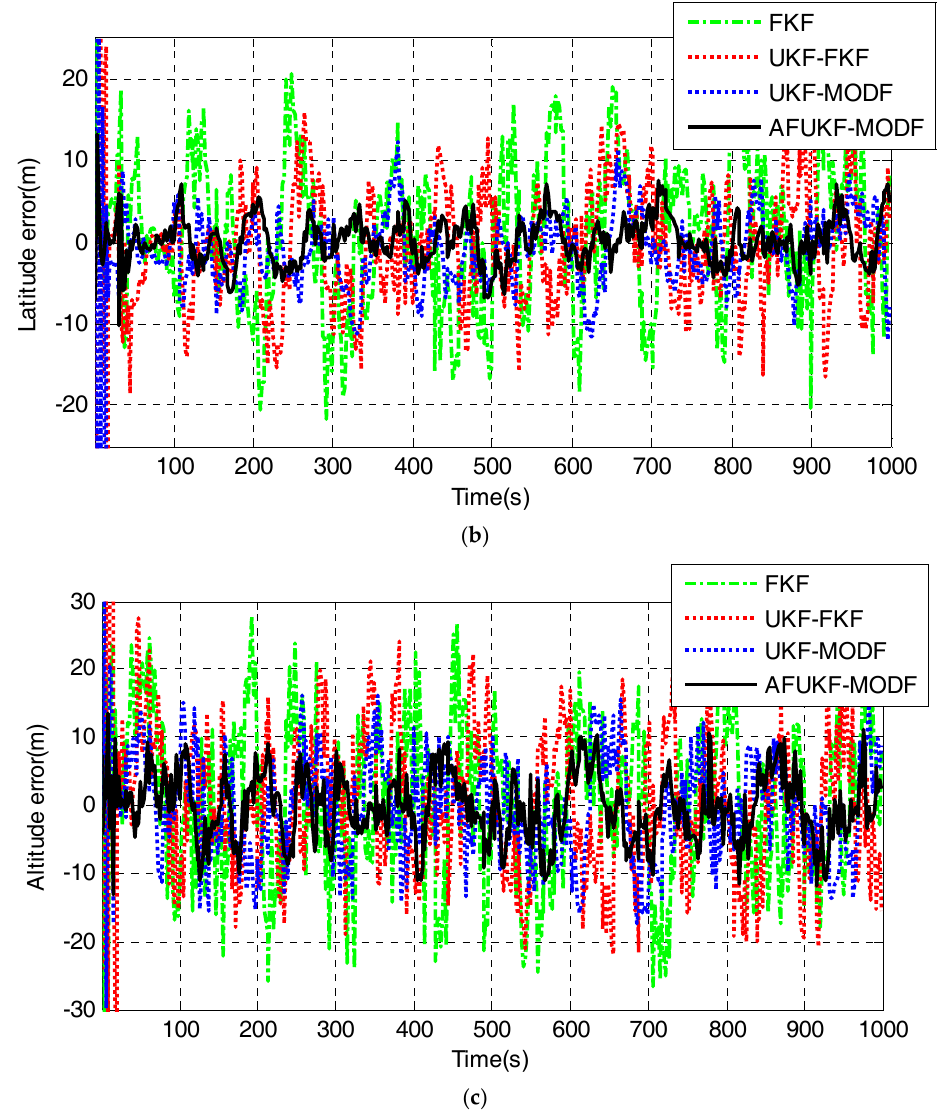
Figure 7. The position errors obtained by FKF, UKF-FKF, UKF-MODF and AFUKF-MODF for the UAV experiment test: ( a ) Longitude error; ( b ) Latitude error; ( c ) Altitude error. Table 6. MAEs and STDs of the position errors obtained by FKF, UKF-FKF, UKF-MODF and AFUKF-MODF for the UAV experiment test.